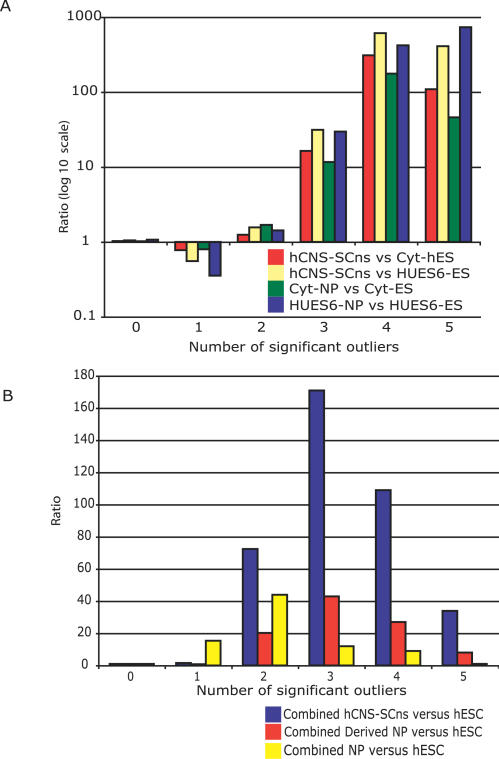
Correlation between “Outliers”(A) The number of probesets with N significant “outliers” was determined for hCNS-SCns versus Cyt-ES, hCNS-SCns versus HUES6-ES, Cyt-NPs versus Cyt-ES, and HUES6-NPs versus HUES6-ES (N = 0, 1, 2, 3, 4, 5). For comparison, points to probeset relationships were randomly permuted, retaining the same number of “outliers.” Vertical bars represent the ratio between the number of actual points and the randomly permutated sets.(B) Similar to (A), except points were counted as “outliers” only if they were “outliers” in both hCNS-SCns versus Cyt-ES and hCNS-SCns versus HUES6-ES (combined hCNS-SCns versus hESC; blue bars); in both HUES6-NP versus HUES6-ES and Cyt-NP versus Cyt-ES (combined derived NP versus hESC; red bars); and in all four comparisons (combined NP versus hESC; yellow bar).